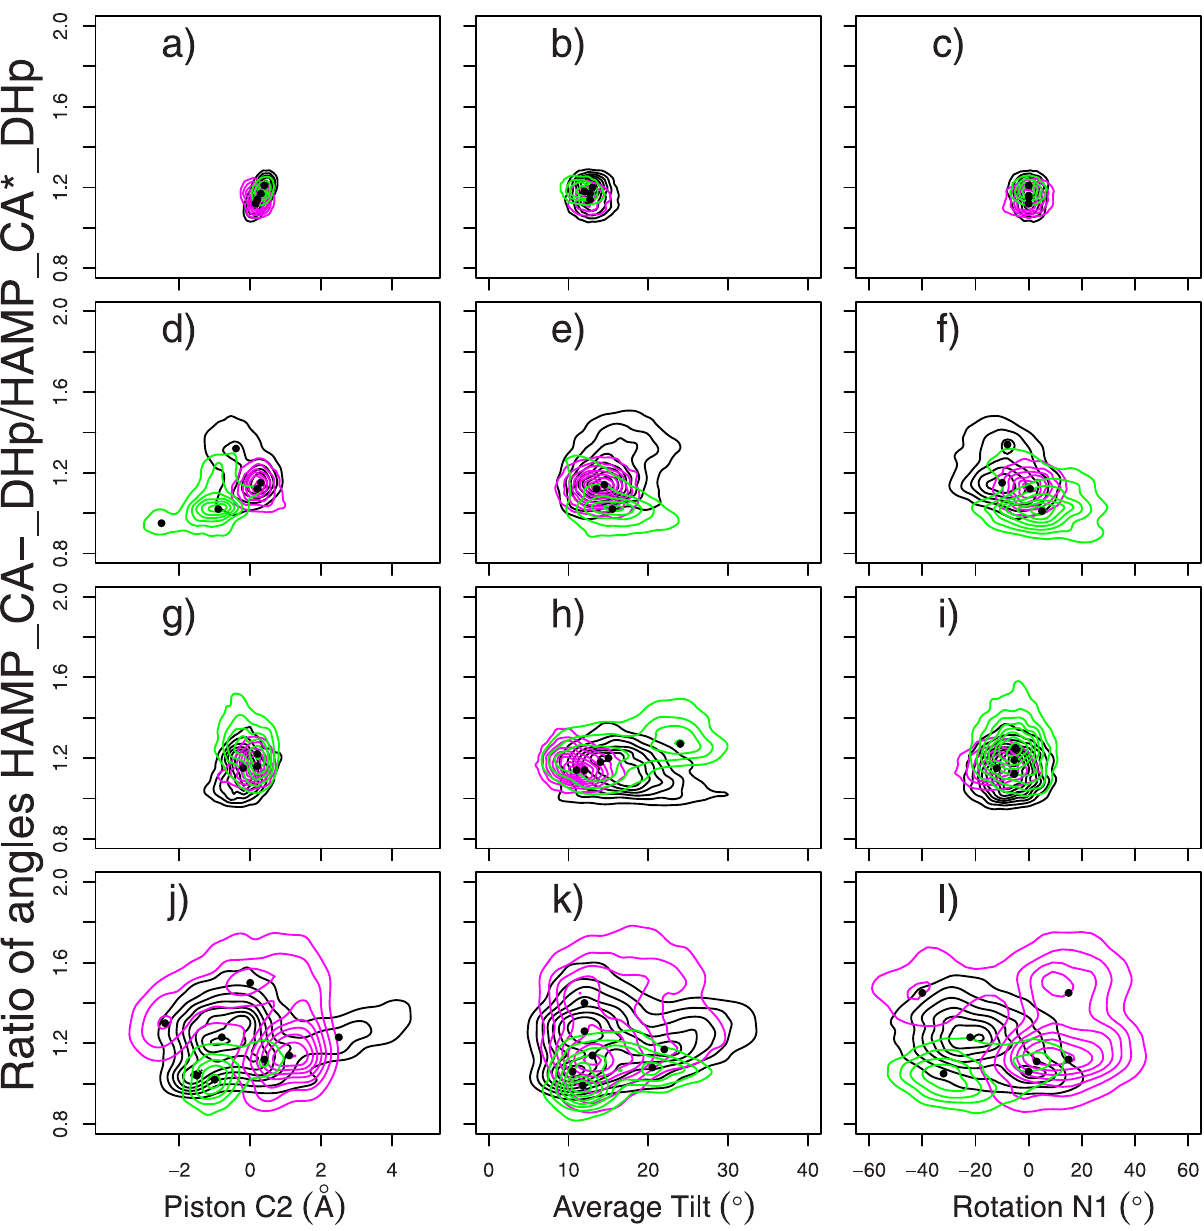
Fig 4. Correlation of HAMP motions to the ratio of the angles HAMP-CA − -DHp and HAMP-CA � -DHp. Ratio θ HAD / θ HA � D of the angles HAMP-CA − -DHp and HAMP-CA � -DHp plotted along parameters describing the relative positions of HAMP α helices: Piston C2 (Eq 5), Rotation N1 (Eq 6) and average Tilt (Eq 7). The distributions are plotted for various trajectories: (a-c) MD, (d-f) dbl15, (g-i) mid15, (j-l) tet20. The contour plots of the distribution are colored according to the replicates, in the same way than in Fig 2. The locations of local maxima in distributions are marked with